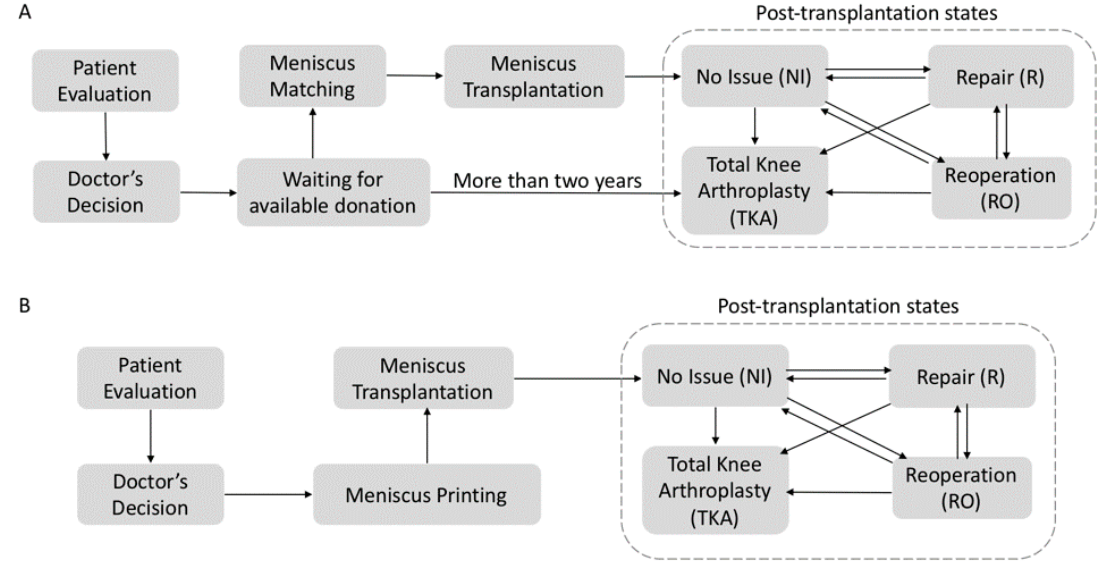
Figure 2. Pathway models of meniscus transplantation: ( A ) traditional vs. ( B ) 3DP-enabled.